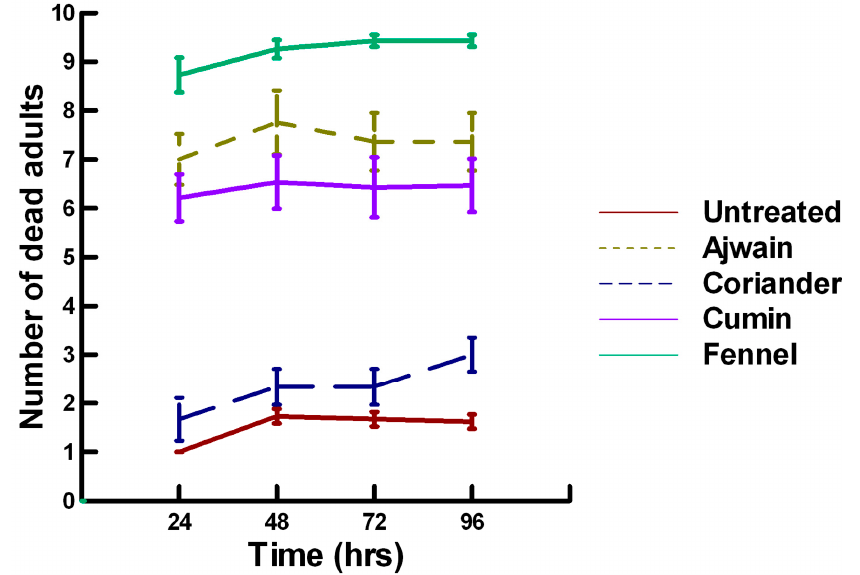
Figure 5. Acute contact toxicity with a high concentration of plant powders from the family Apiaceae (Ajwain, coriander, cumin and fennel) adherent to adult Pteromalus venustus . Means and standard error shown.